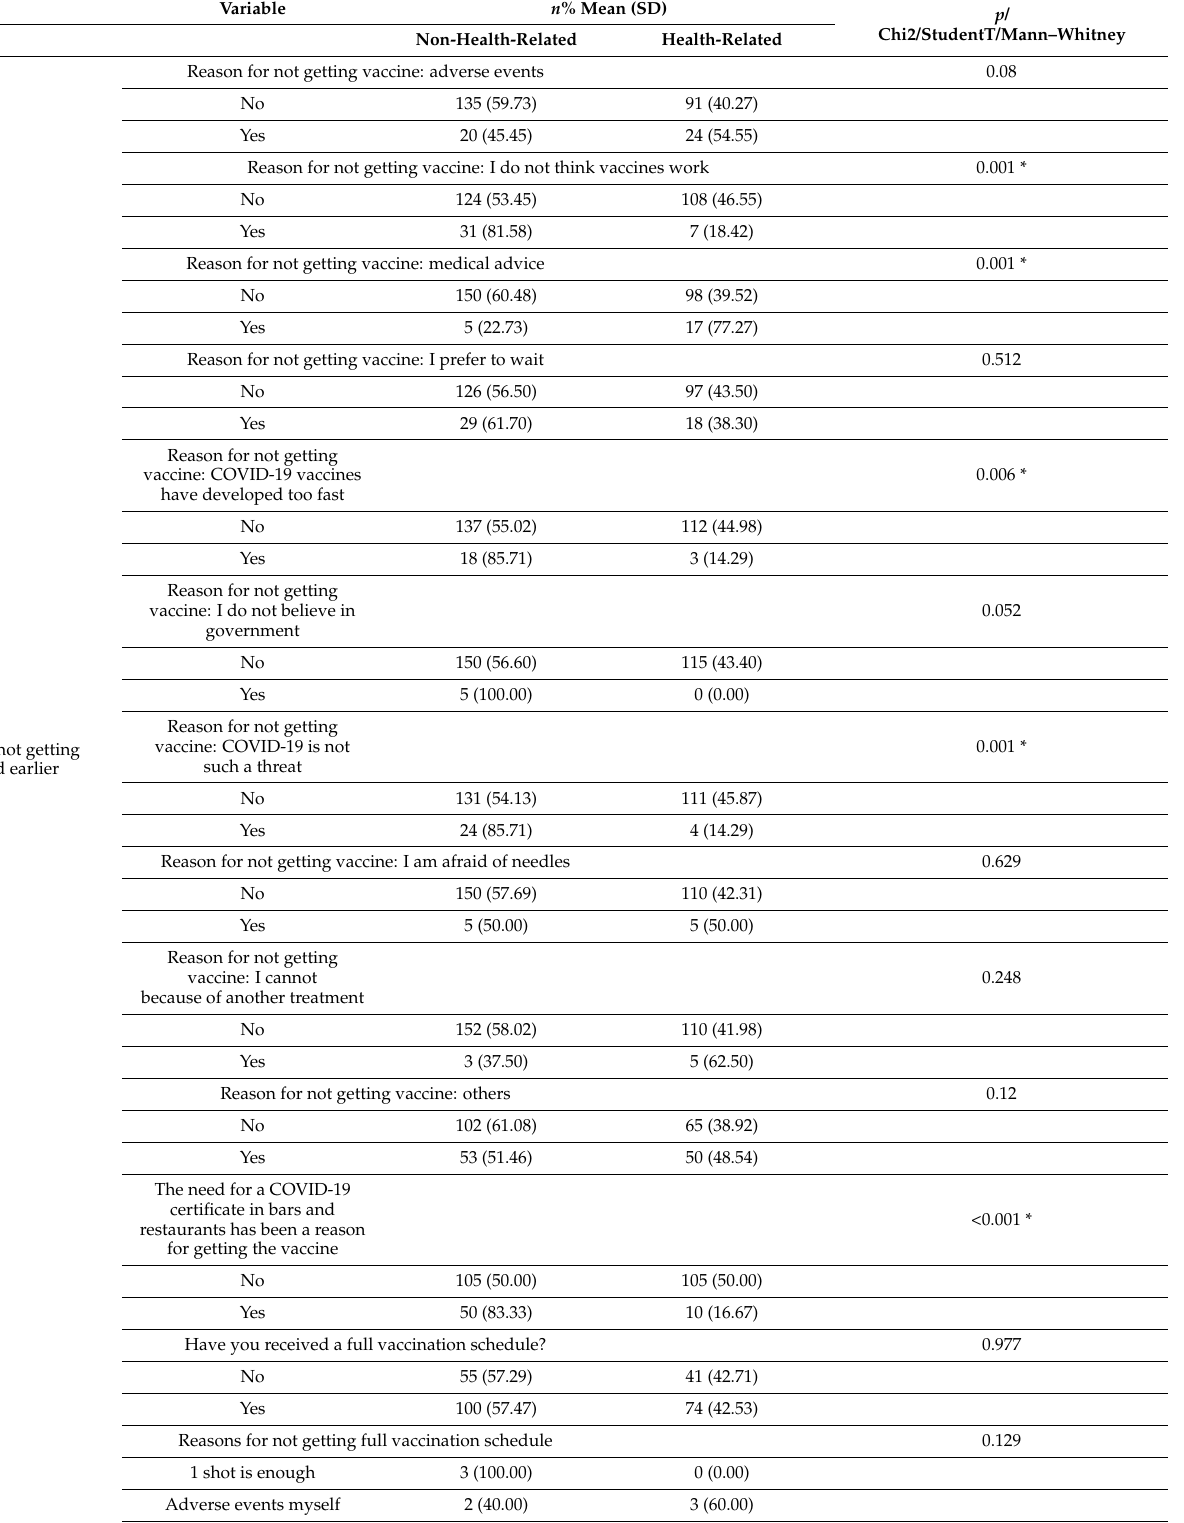
Table 4. Bivariate analysis by reasons for not getting primary vaccination